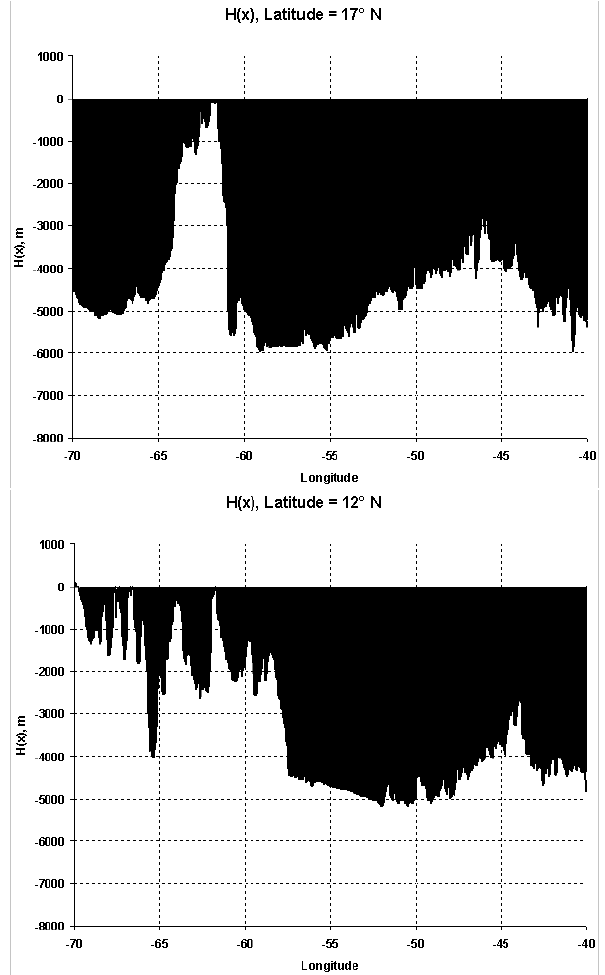
Figure 7. Radon transform at 17ºN (top) and at 12ºN (bottom) before (solid line) Fig. 7. Radon transform at 17 ◦ N (top) and at 12 ◦ N (bottom) before and after (dashed line) the LA. (solid line) and after (dashed line) the ◦ N (top) and along 12 ◦ N Figure 6. Bottom topography (m) along 17ºN (top) and along 12ºN (bottom). Fig. 6. Bottom topography (m) along 17 (bottom). Figure 6. Bottom topography (m) along 17ºN (top) and along 12ºN (bottom). 21